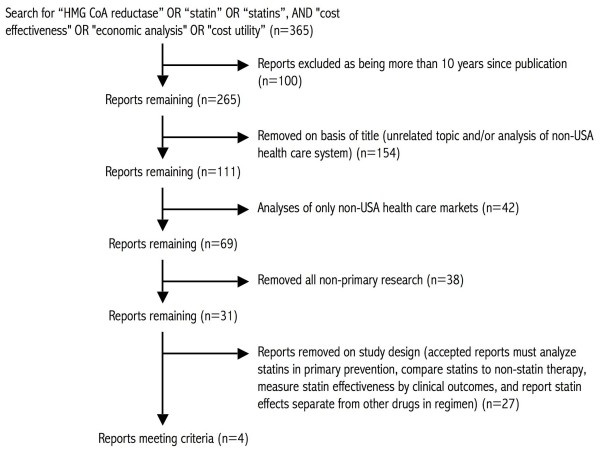
Article selection. Flowchart of article selection.